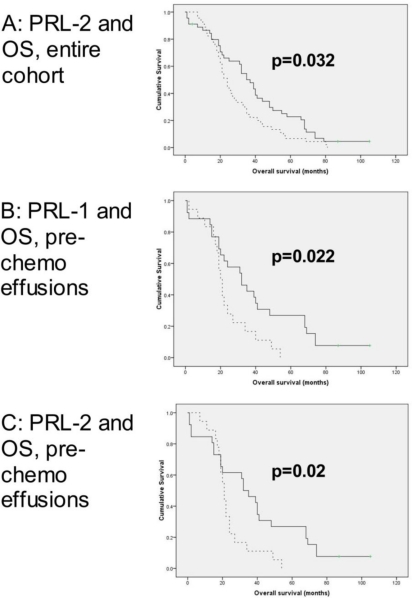
PRL-1 and PRL-2 mRNA expression in OC effusions is associated with longer overall survival (OS). (A) Kaplan-Meier survival curve showing the association between PRL-2 mRNA expression and OS in the entire effusion cohort (n = 90). Patients with effusions having higher than median PRL-2 mRNA levels (n = 45; solid line) had mean OS of 39 months compared to 29 months for patients with lower than median expression levels (n = 45, dashed line; p = 0.032); (B) Kaplan-Meier survival curve showing the association between PRL-1 mRNA expression and OS for women with pre-chemotherapy effusions (n = 44). Patients with effusions having higher than median PRL-1 mRNA levels (n = 26; solid line) had mean OS of 39 months compared to 23 months for patients with lower than median expression levels (n = 18, dashed line; p = 0.022); (C) Kaplan-Meier survival curve showing the association between PRL-2 mRNA expression and OS for women with pre-chemotherapy effusions (n = 44). Patients with effusions having higher than median PRL-2 mRNA levels (n = 26; solid line) had mean OS of 39 months compared to 24 months for patients with lower than median expression levels (n = 18, dashed line; p = 0.02).